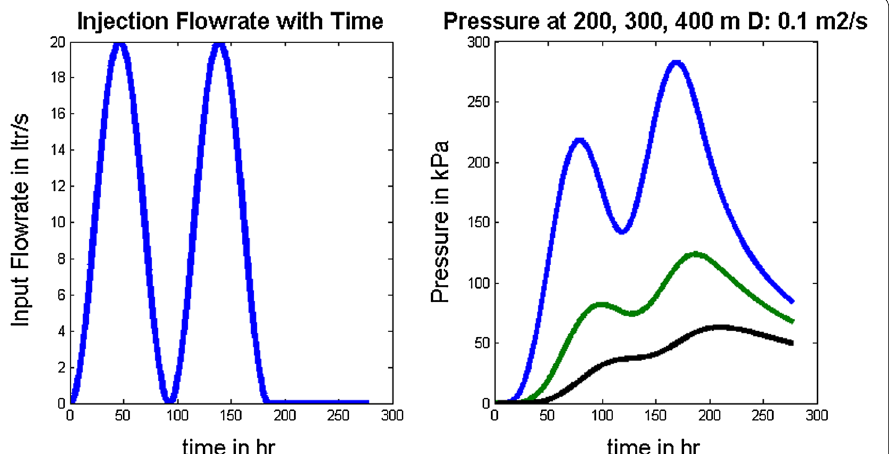
progressively smaller peak to trough pressure